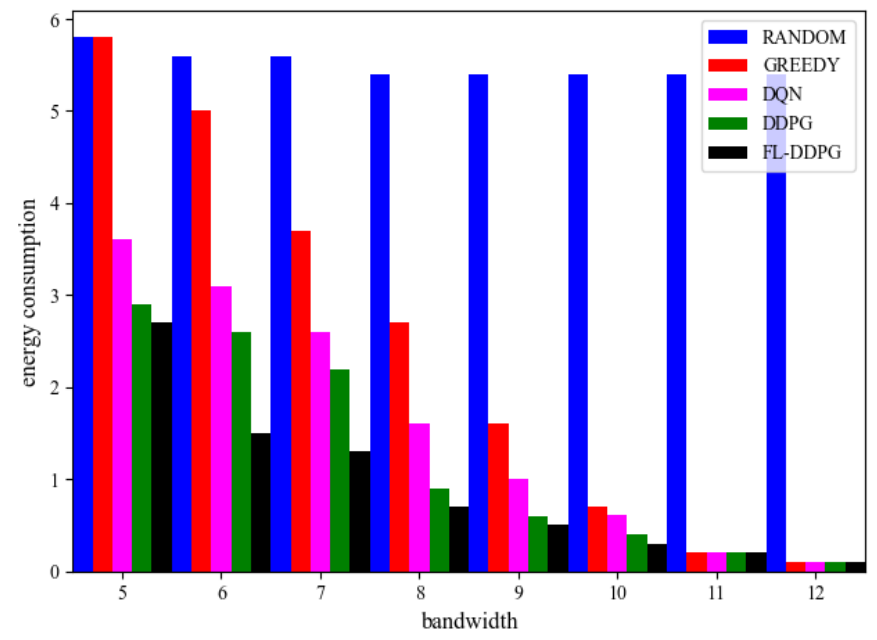
Figure 6. Performance evaluation on energy